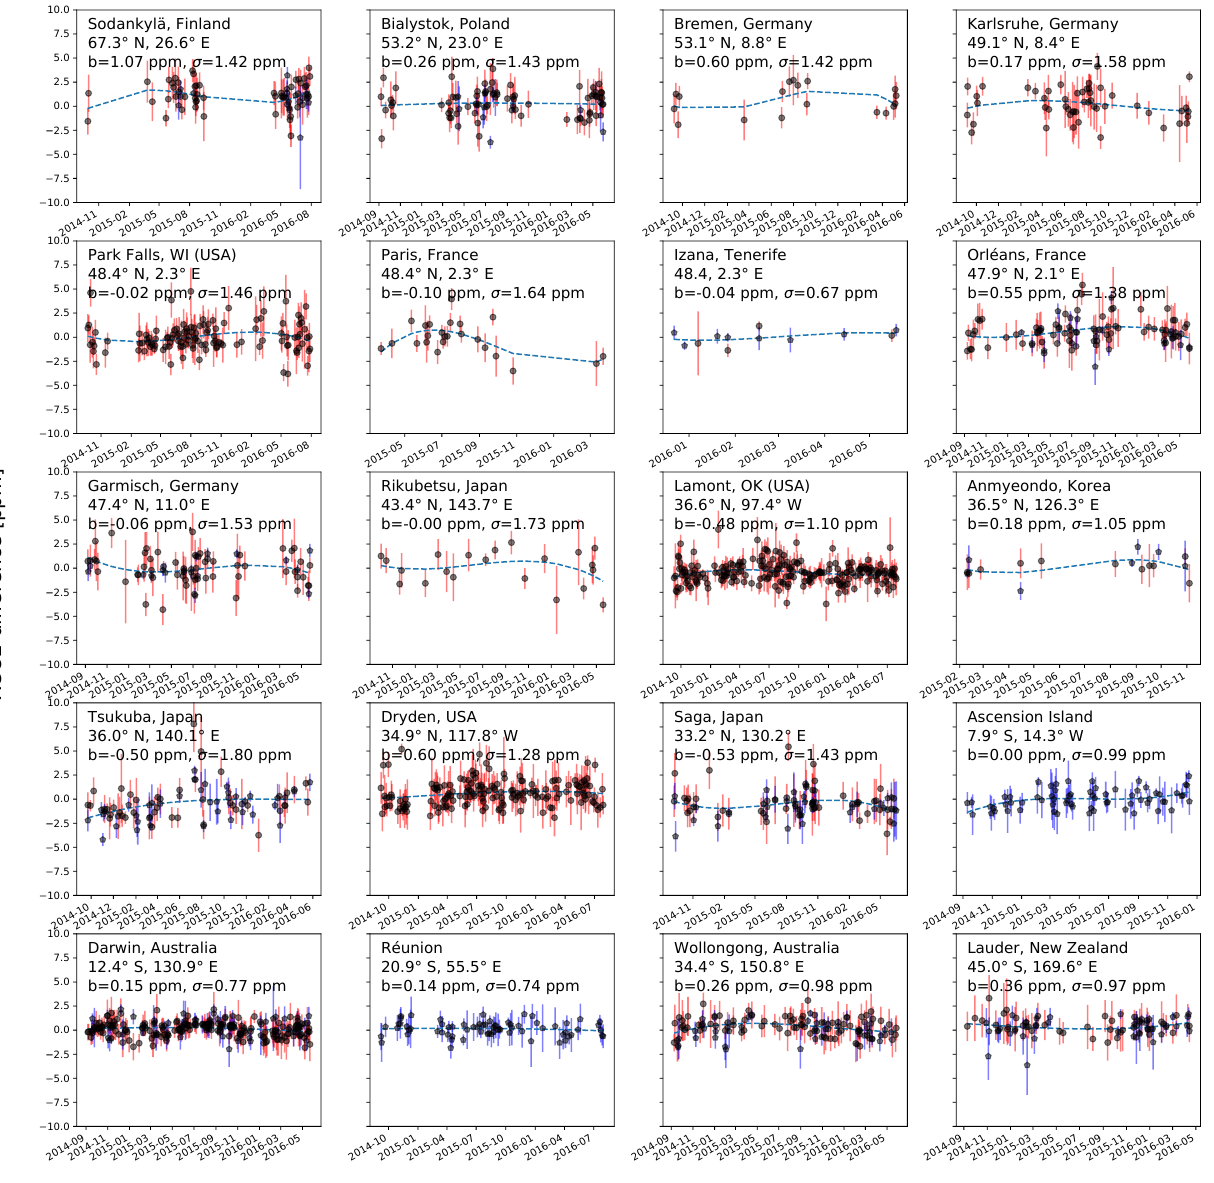
Figure 11. Time variation of X CO difference between retrievals from OCO-2 observations over land (red dots) and ocean (blue pentagon) 2 and collocated TCCON measurements for each TCCON station. SD of individual TCCON measurement and satellite retrievals are presented with the length of bar. In each subplot, the overall bias ( b ), SD ( σ ) and site location in latitude and longitude are included. The shown results here are bias-corrected data used in Table 3. An second-order polynomial (blue dot lines) is fitted for distinguishing the time-variation of